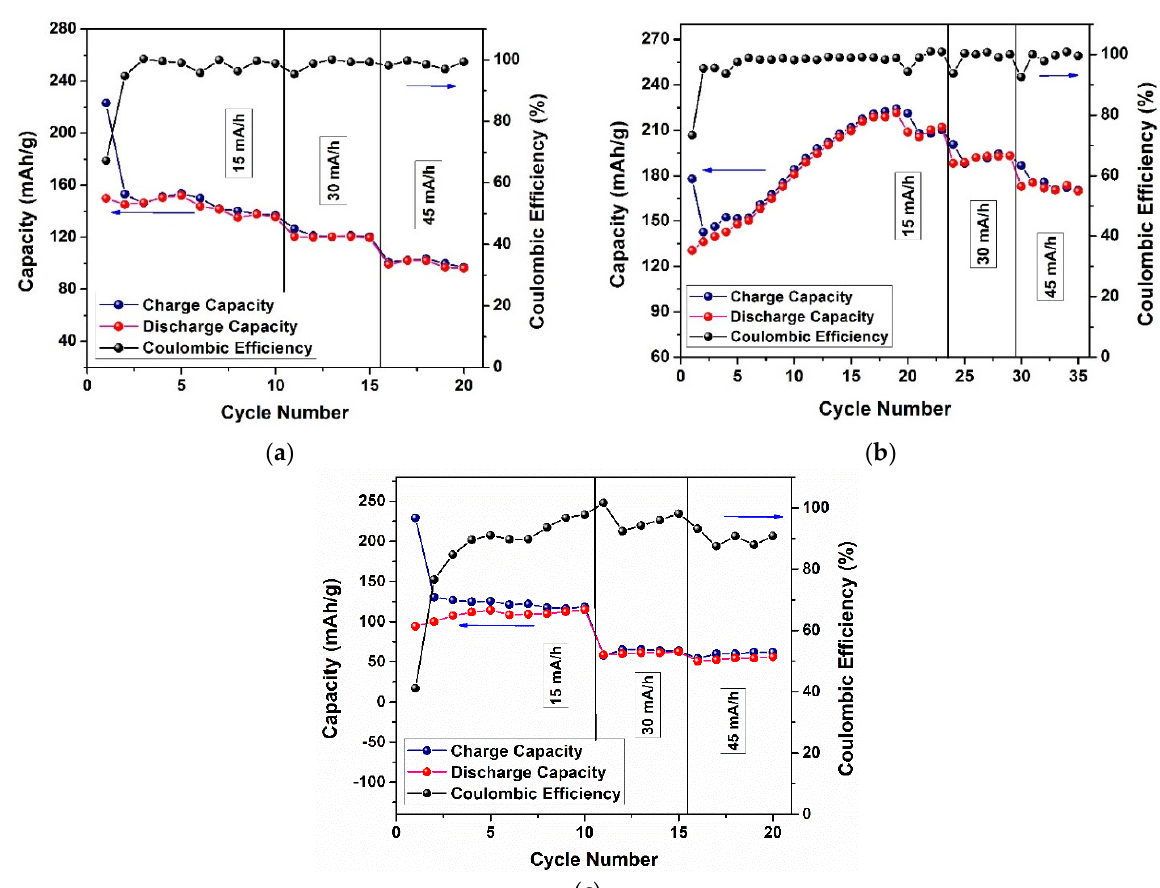
Figure 8. Charge–discharge capacity and coulombic efficiency through cycling for ( a ) 0.3Li 2 MnO 3 – 0.7LiNi 0.5 Mn 0.5 O 2 , ( b ) 0.5Li 2 MnO 3 –0.5LiNi 0.5 Mn 0.5 O 2 , and ( c ) 0.7Li 2 MnO 3 –0.3LiNi 0.5 Mn 0.5 O 2 cathode materials.